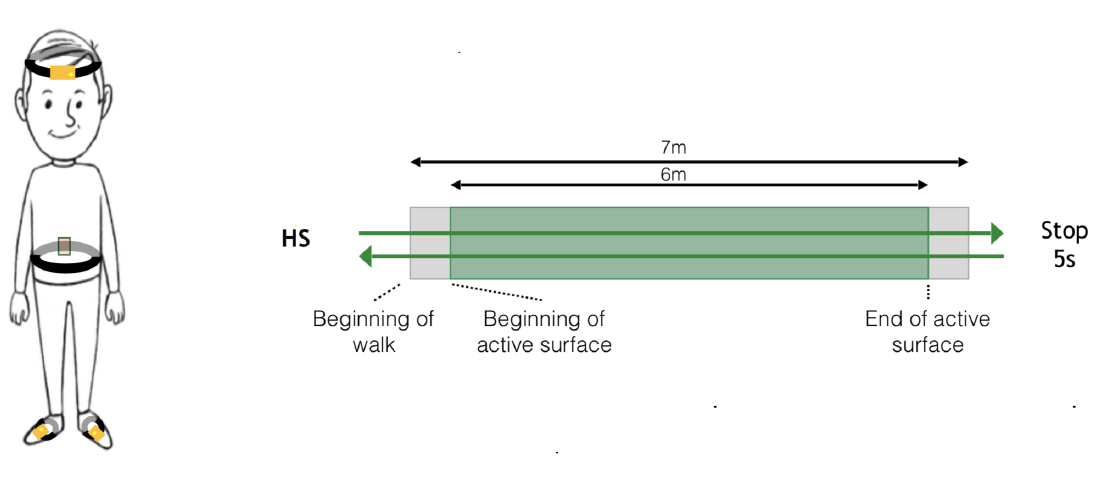
Figure 3. Gait Measure: synchronised Xsens-GaitRite. For healthy subjects, the U-turn is not on the